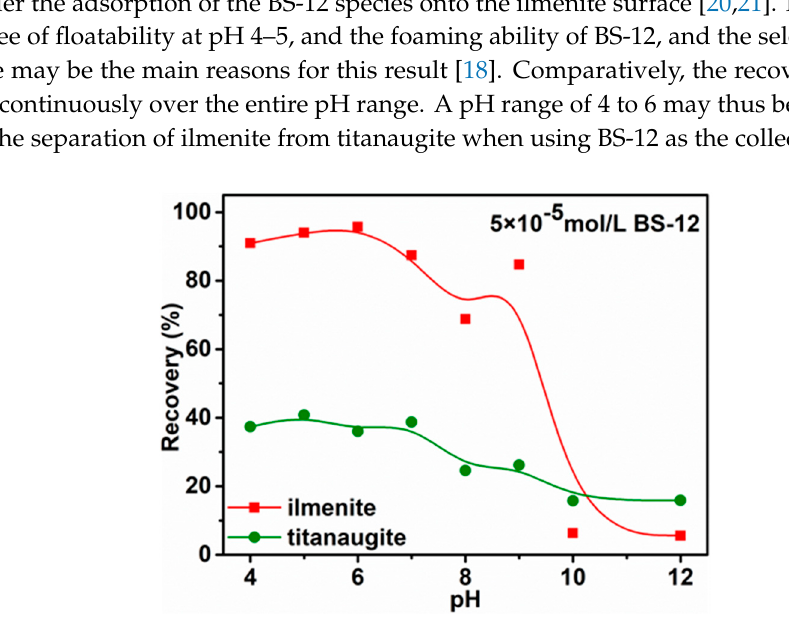
Figure 3. Flotation recovery of ilmenite and titanaugite as a function of pH.